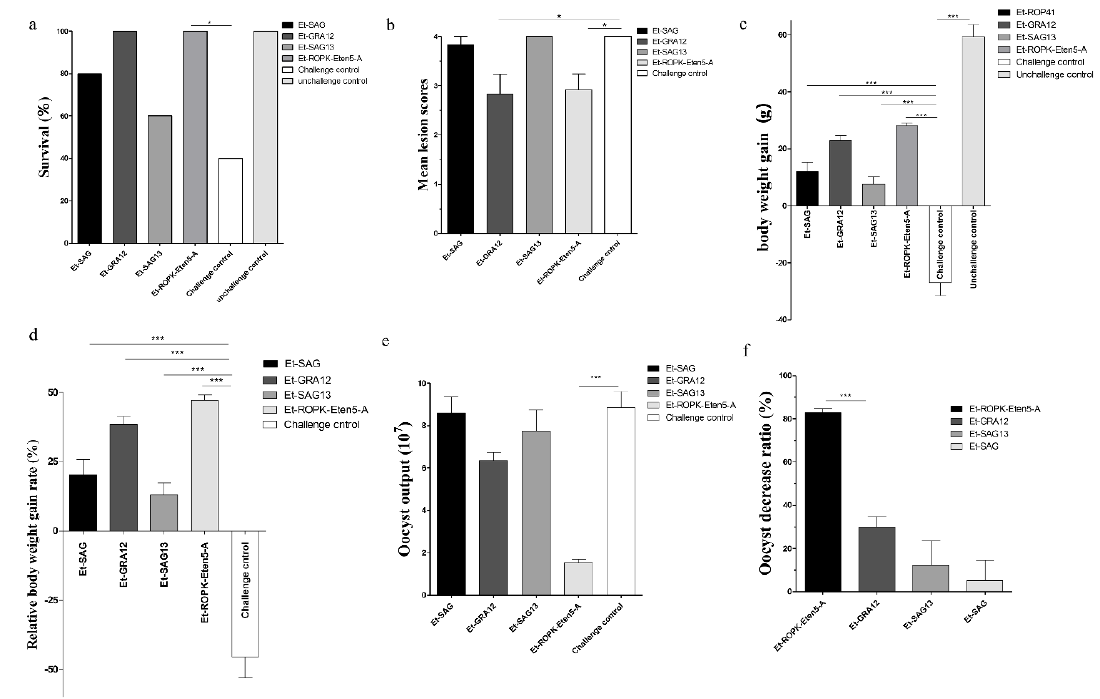
Figure 7. Protective efficacy of the four sporozoite antigens against E. tenella. ( a ) Effects of vaccination with four sporozoite antigens on survival rate, ( b ) cecum lesion score, ( c ) body weight gain, ( d ) relative body weight gain, ( e ) oocyst output and ( f ) oocyst decrease rate. Data are the means ± SD (error bars) of three independent experiments. All data were analyzed using t -tests. p -values are represented by asterisks as follows: * p < 0.05, and *** p < 0.001.